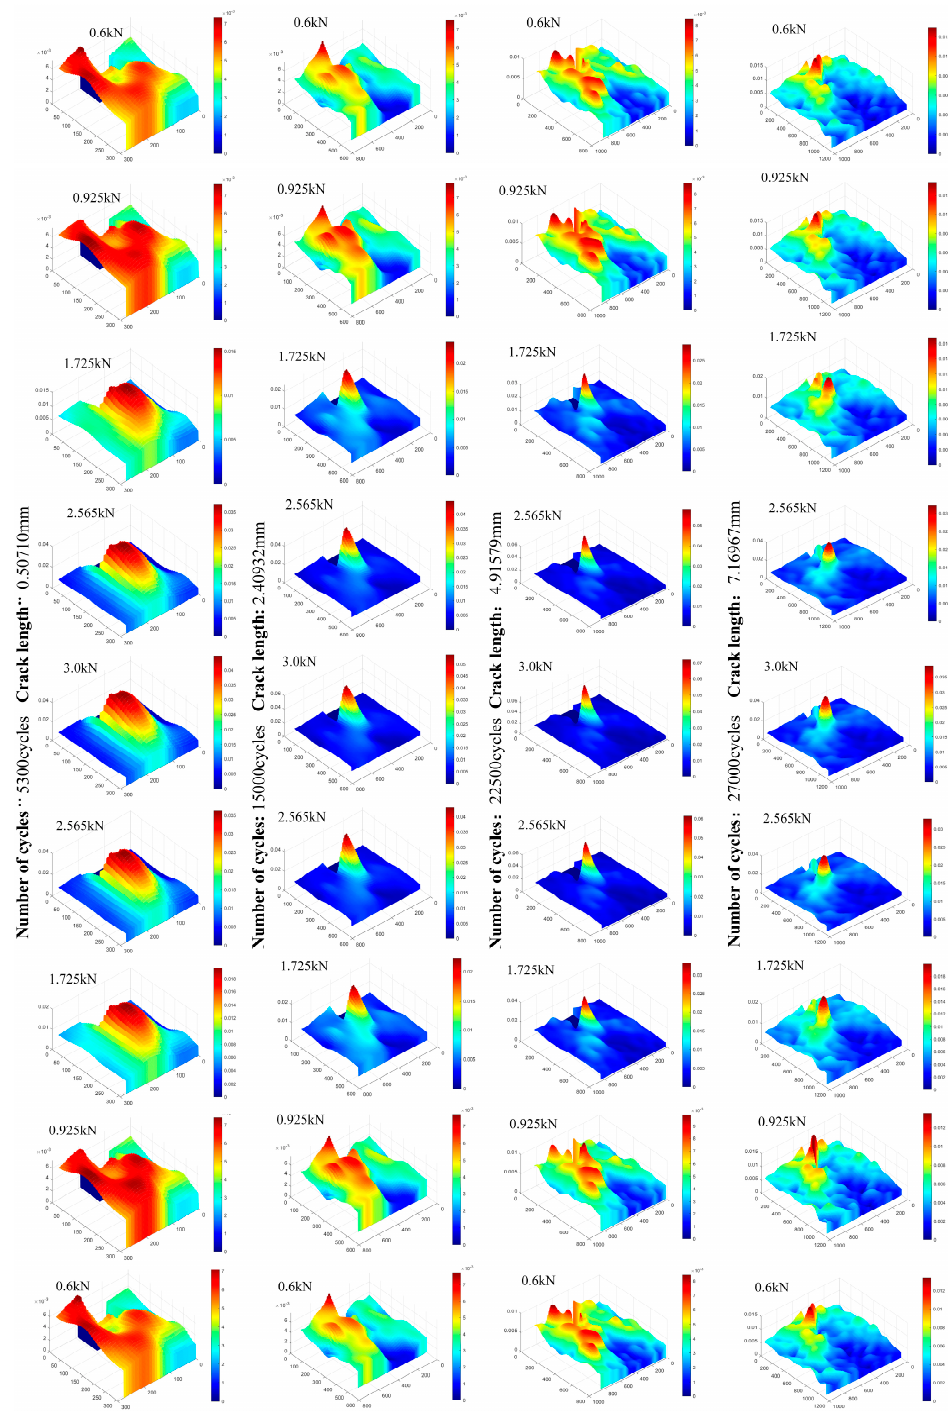
Figure 20. Variation of the von Mises strain field in one period with different crack lengths. After confirming the validity and accuracy of this method, we performed the same test with another material, 316L. In-situ measurement of the strain field was similarly